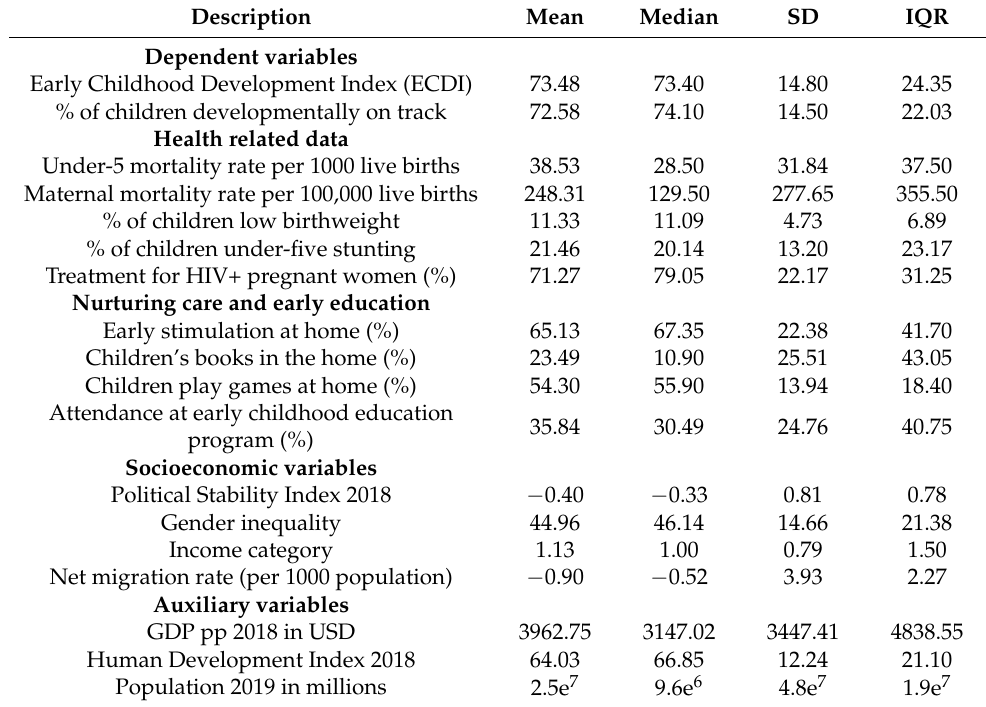
Table 3. Descriptive statistics ( N = 68 low-and-middle income countries (LMICs)).